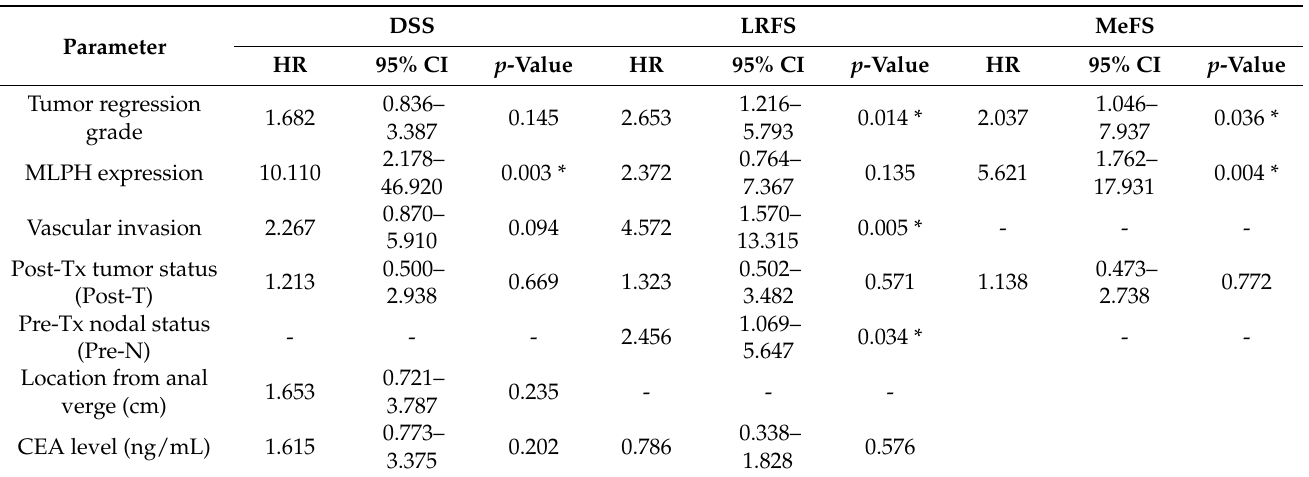
Figure 3. Kaplan-Meier survival between high and low melanophilin (MLPH) in 172 rectal cancer patients: ( A ) disease- specific survival; ( B ) recurrence-free survival; and ( C ) metastasis-free survival. Table 4. Multivariate